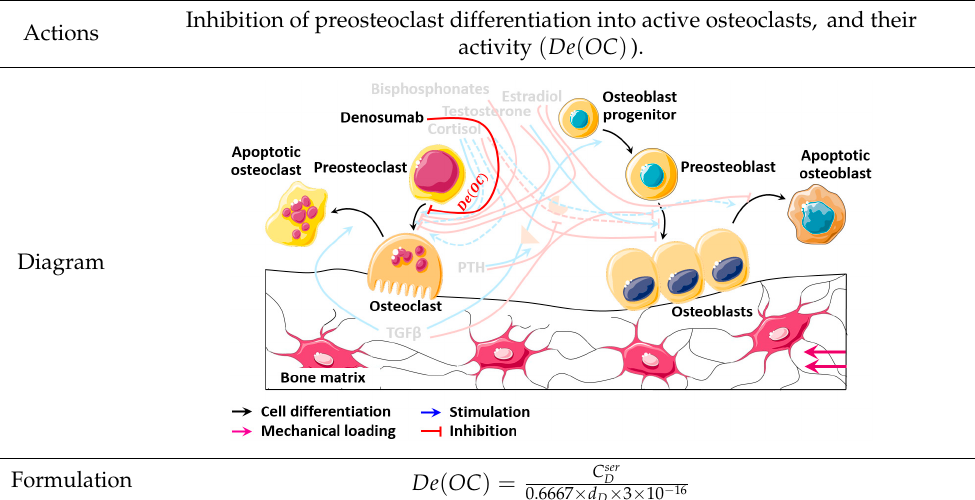
Table 7. Denosumab actions and their mathematical formulation.